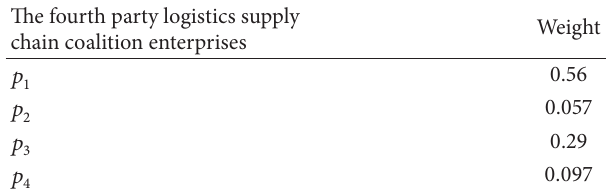
Table 2: Weight of